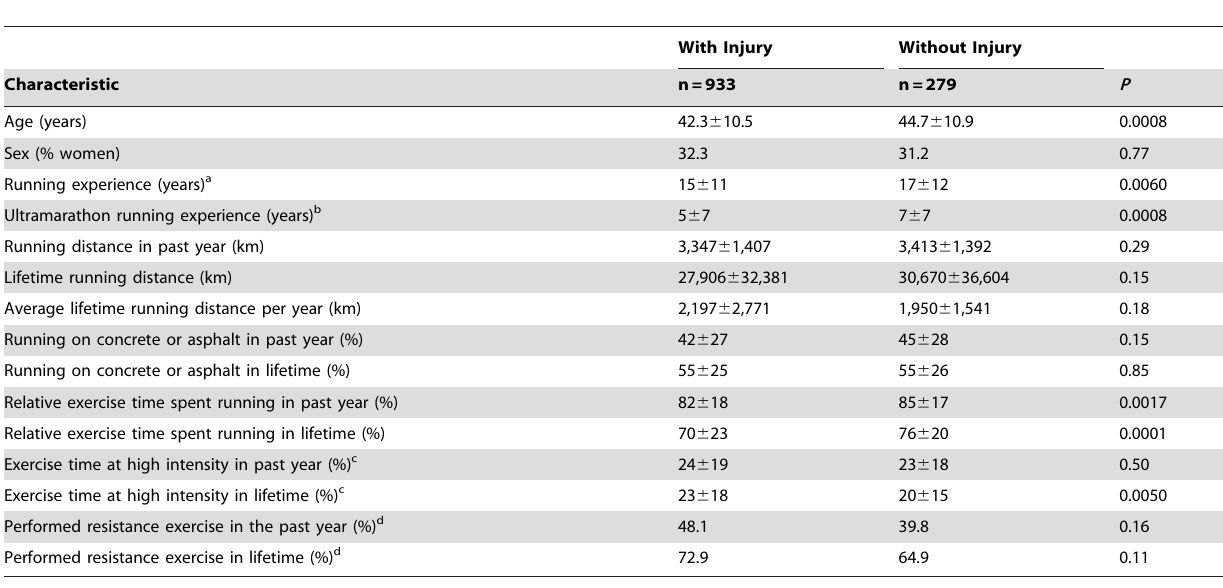
Table 6. Comparison of select characteristics of those reporting an exercise-related injury in the prior 12 months with those who had not been injured.